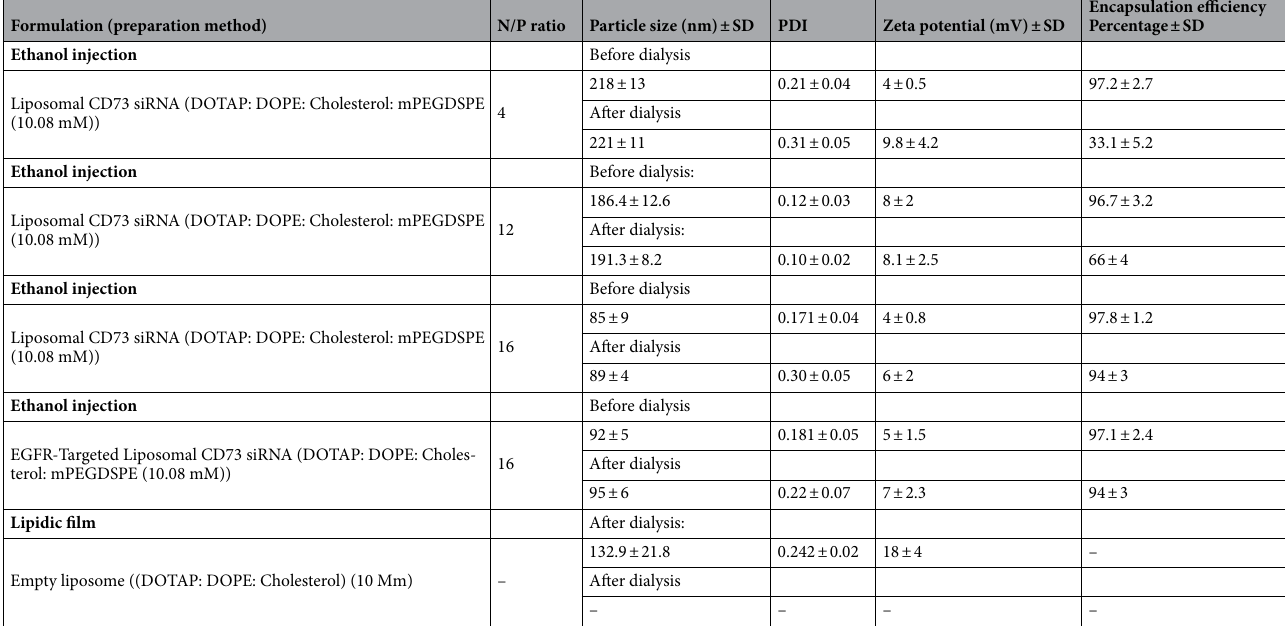
Table 1. Effect of N/P ratio on size, zeta potential, and encapsulation efficiency (EE) of nanolipoparticles containing CD73